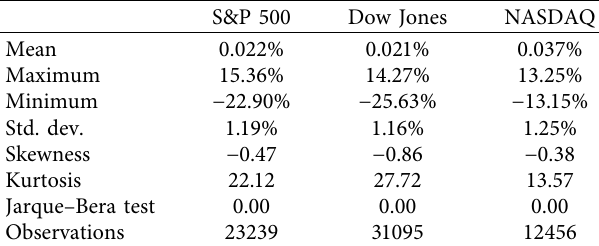
Table 1: Descriptive statistics of daily returns of stock indices.